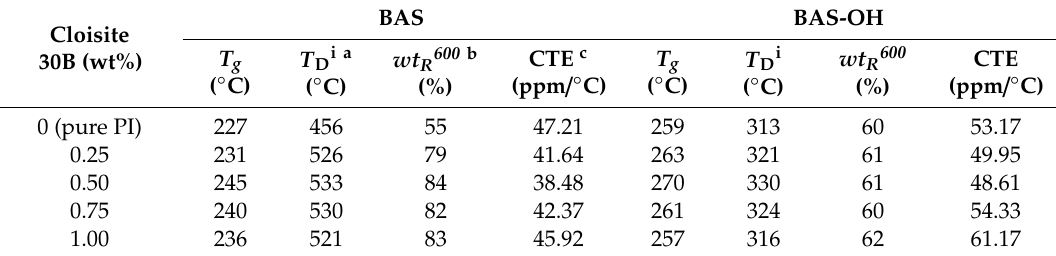
Table 2. Thermal properties of PI hybrid films with various organoclay contents.